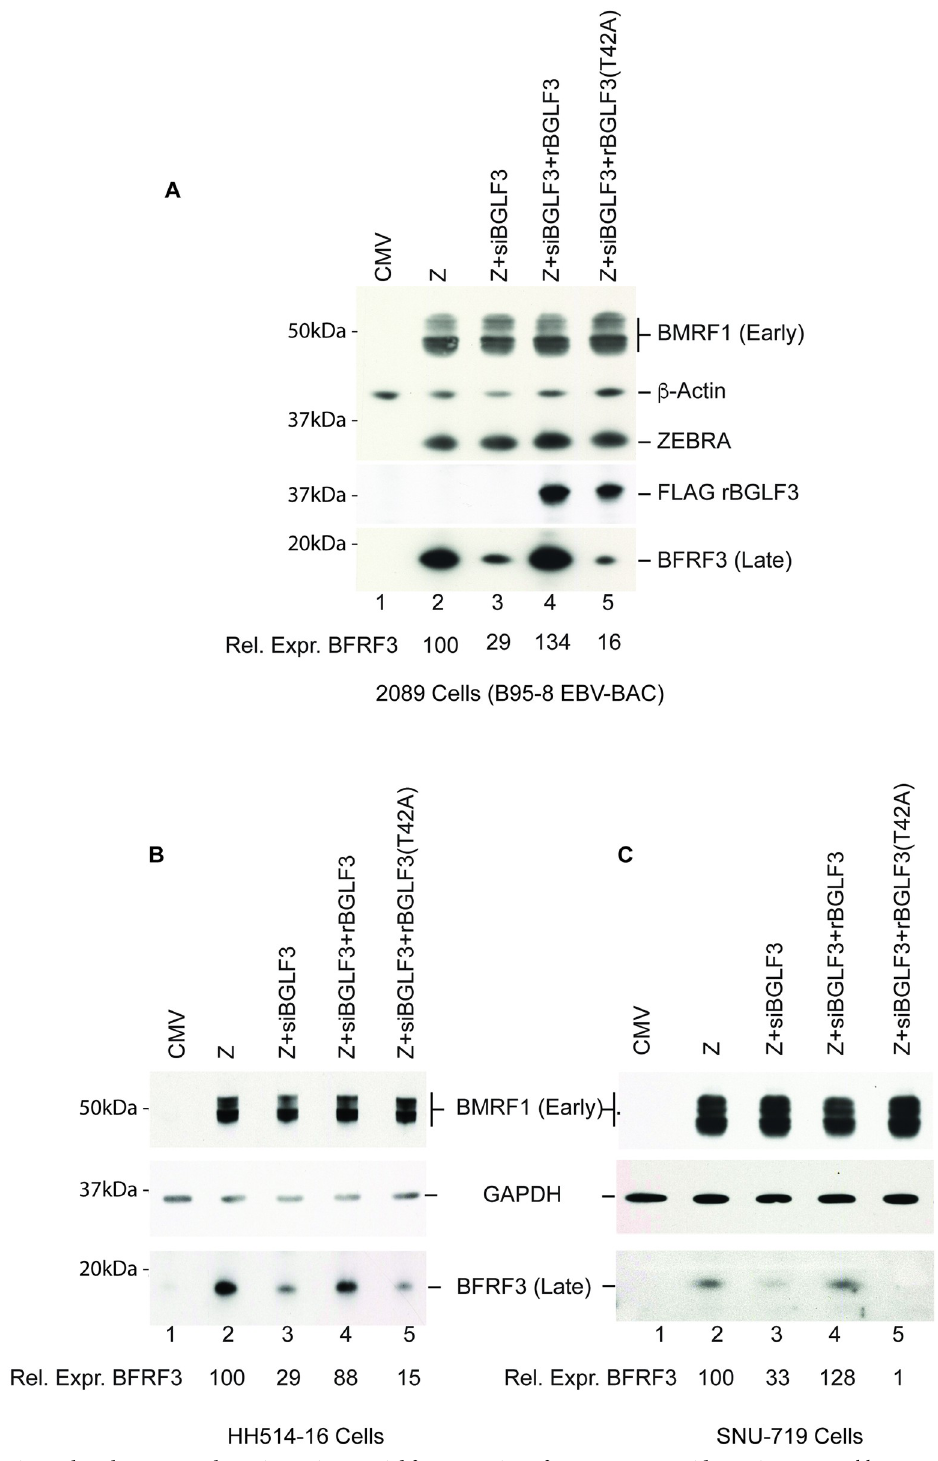
Fig 2. Phosphoacceptor threonine 42 is essential for expression of EBV BFRF3 capsid protein. Western blot analysis to study the effect of substituting threonine 42 in BGLF3 to alanine on viral gene expression. 2089 (A), Burkitt lymphoma HH514-16 (B) and gastric carcinoma SNU-719 (C) cells were transfected with the indicated expression vectors. Expression of endogenous BGLF3 was eliminated using siRNA to BGLF3 (siBGLF3). siRNA-resistant wild type BGLF3 (rBGLF3) and mutant BGLF3 [rBGLF3(T42A)] were provided ectopically to complement the lack of